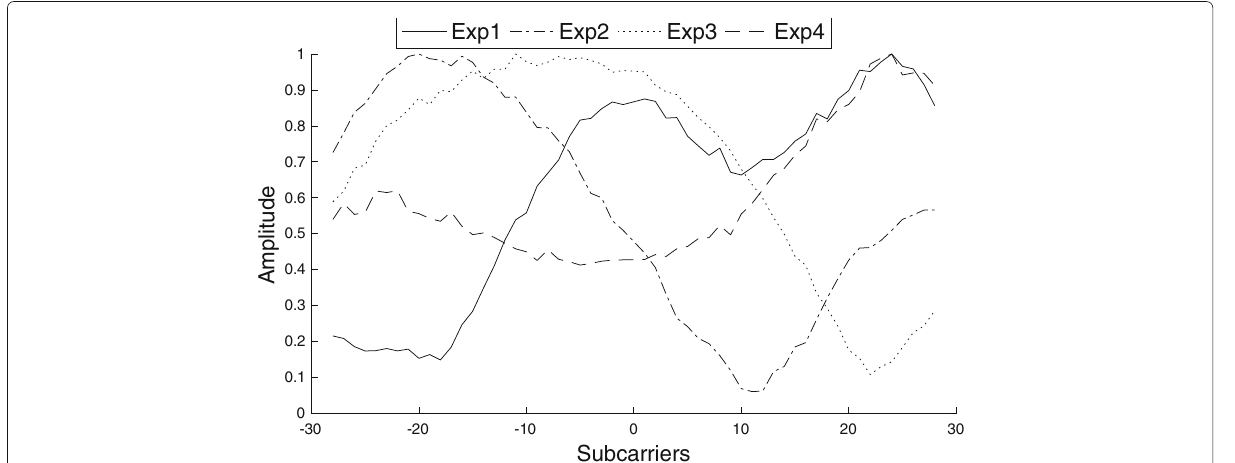
Fig. 4 Absolute values of some measured CSI. The absolute value of the CSI across 64 subcarriers is shown for the strongest antenna pair in four experiments